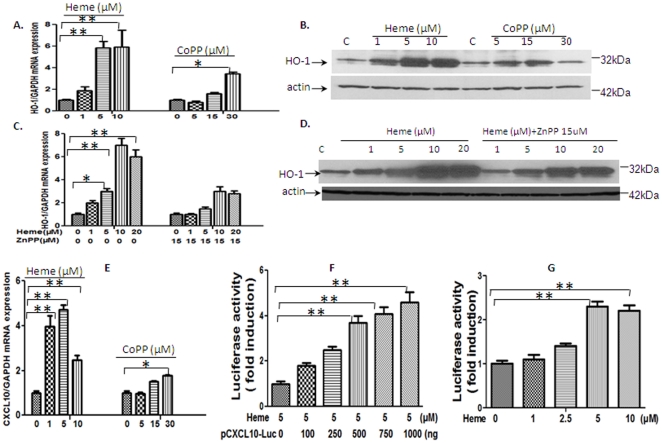
HO-1 and CXCL10 are induced by Heme and its synthetic inducer in mouse endothelial CRL2581 cell line.We exposed mouse brain endothelial cell line CRL-2581 in vitro with Heme at different concentration. The results show that expression of HO-1 mRNA (A) and protein (B) are significantly up-regulated by Heme and HO-1 enzymatic inducer-CoPP treatment. HO-1 expression peaked at 5–10 µM for Heme and 5–15 µM for CoPP. HO-1 mRNA (C) and protein (D) were down-regulated by HO-1 enzymatic activity inhibitor-ZnPP. The expression of CXCL10 mRNA (E) were also significantly up-regulated by Heme and CoPP treatment. The CXCL10 promoter activity is proportional to amounts of CXCL10 luc (F) within the range between 100 ng to 1000 ng when treated with Heme. Figure 7G showed that Heme enhanced the CXCL10 promoter activity in a dose-dependent matter within the range from 1 µM to 5 µM. Data are shown as mean ± SD. *P<0.05; ** P<0.01.